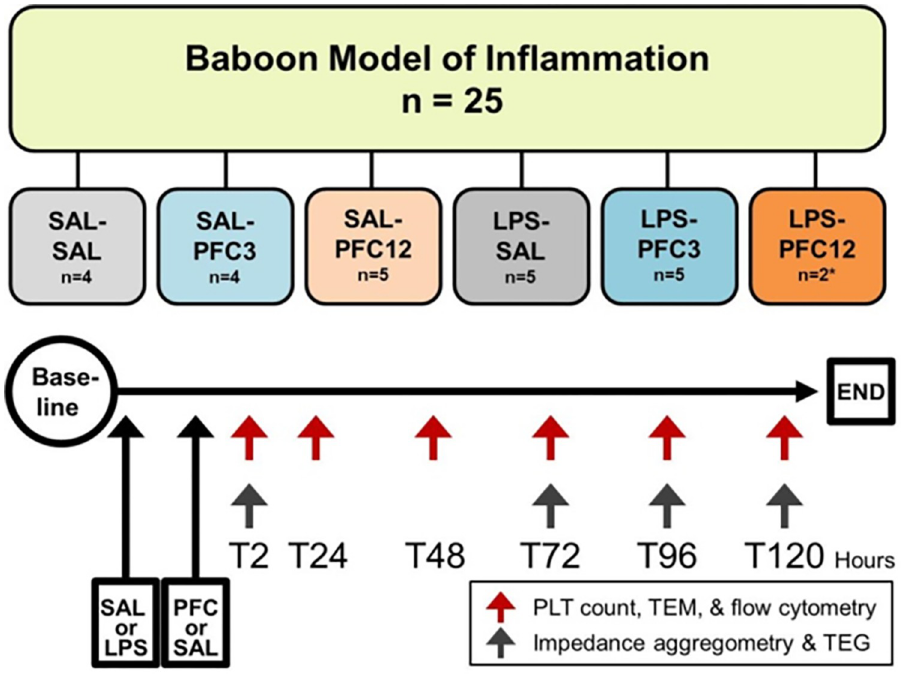
Fig 1. Study groups and experimental